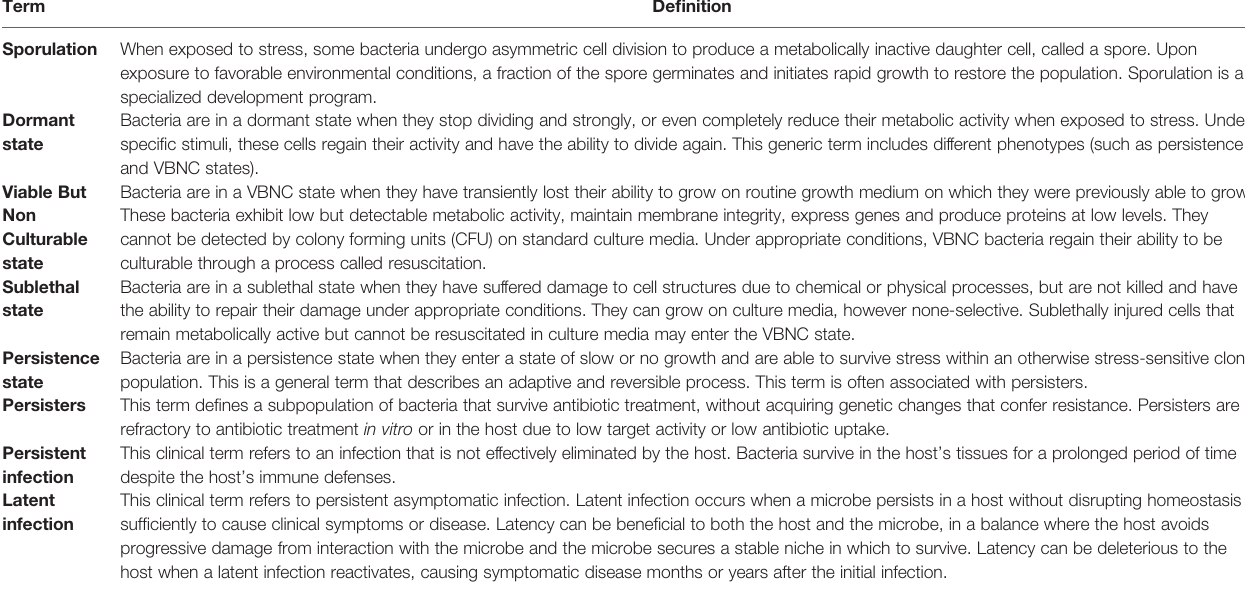
TABLE 2 | De fi nitions of terms used to describe different survival strategies of bacteria to cope with environmental, antimicrobial, or host-derived stress. Term De fi nition Sporulation When exposed to stress, some bacteria undergo asymmetric cell division to produce a metabolically inactive daughter cell, called a spore. Upon exposure to favorable environmental conditions, a fraction of the spore germinates and initiates rapid growth to restore the population. Sporulation is a specialized development program.